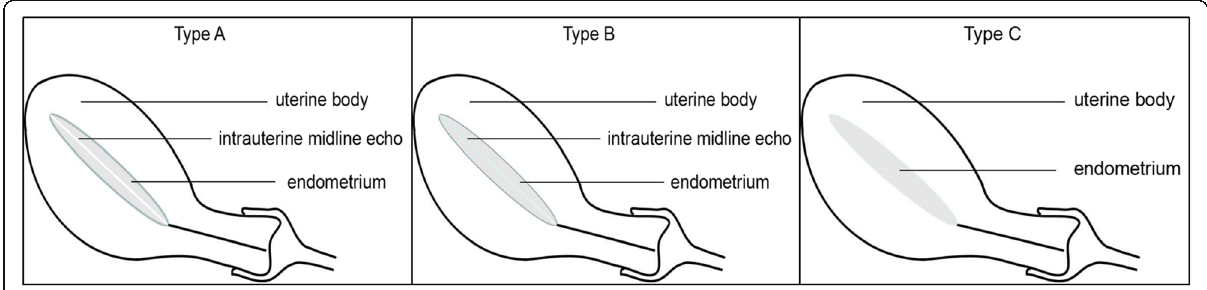
Fig. 1 Endometrial patterns based on the Gonen system. Type A: trilaminar pattern (endometrial three-layer pattern) consisting of hyperechoic outer and middle layers, hypoechoic inner layers, and evident echo at the intrauterine midline; type B: relatively homogeneous hyperechoic endometrium, with unclear endometrial layers, obscure intrauterine midline echo, but clear interface between endometrial and muscular layers; type C: homogeneous hyperechoic endometrium without intrauterine midline